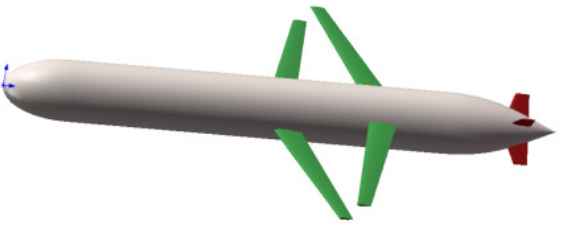
Figure 2. Concept model for the hydrodynamic shape based on the AUG Sea-wing . Table 1. Main dimension parameters of the